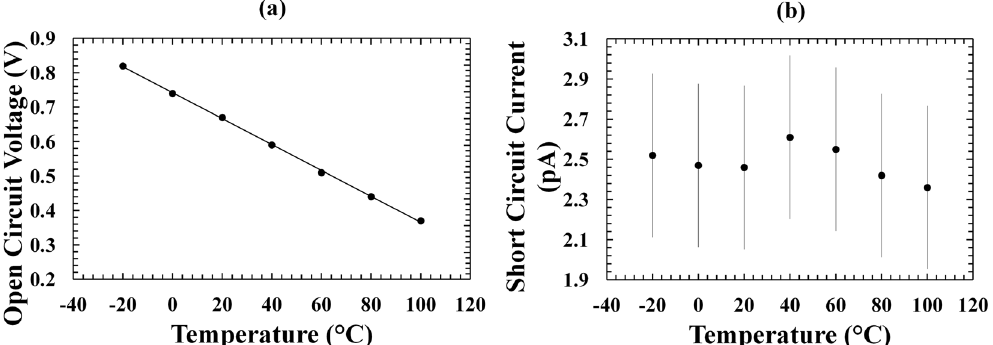
Figure 5. ( a ) Open circuit voltage as a function of temperature for the 55 Fe X-ray photovoltaic In 0.5 Ga 0.5 P cell. Also shown is the line of the best fit computed by linear least squares fitting on the experimental data. ( b ) Short circuit current as a function of temperature for the 55 Fe X-ray photovoltaic In 0.5 Ga 0.5 P